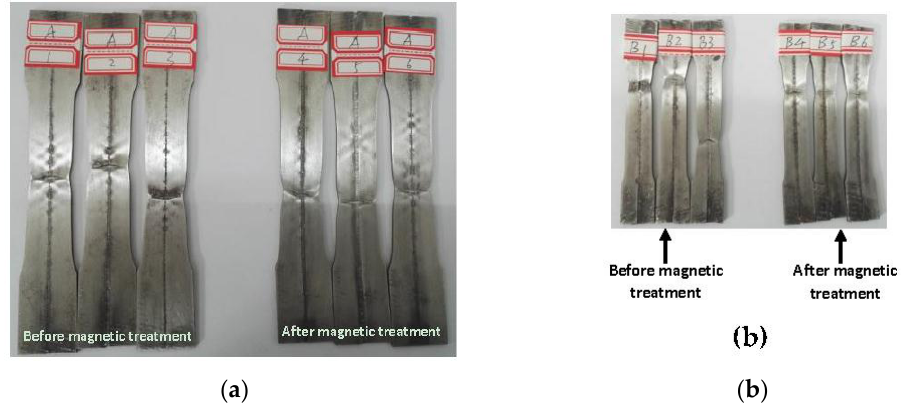
Figure 3. The test samples after uniaxial tensile tests: ( a ) large size; and ( b ) small size.